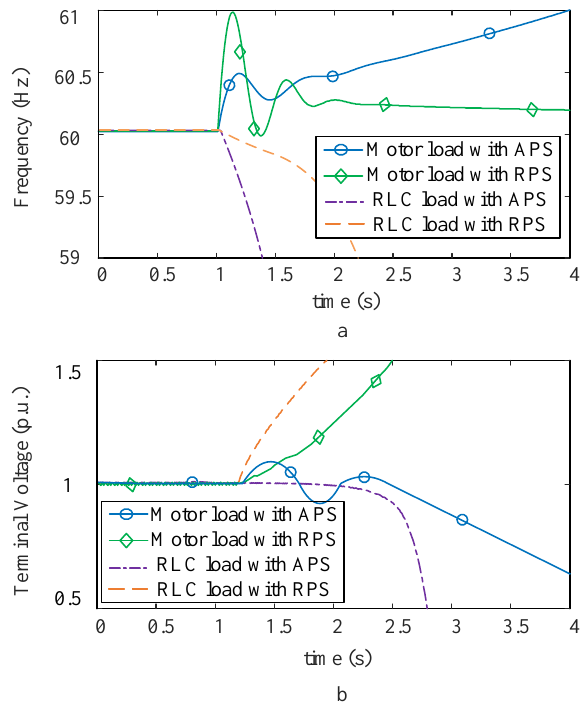
Figure 8. Islanding simulation results; ( a ) frequency ( b ) terminal voltage of synchronous